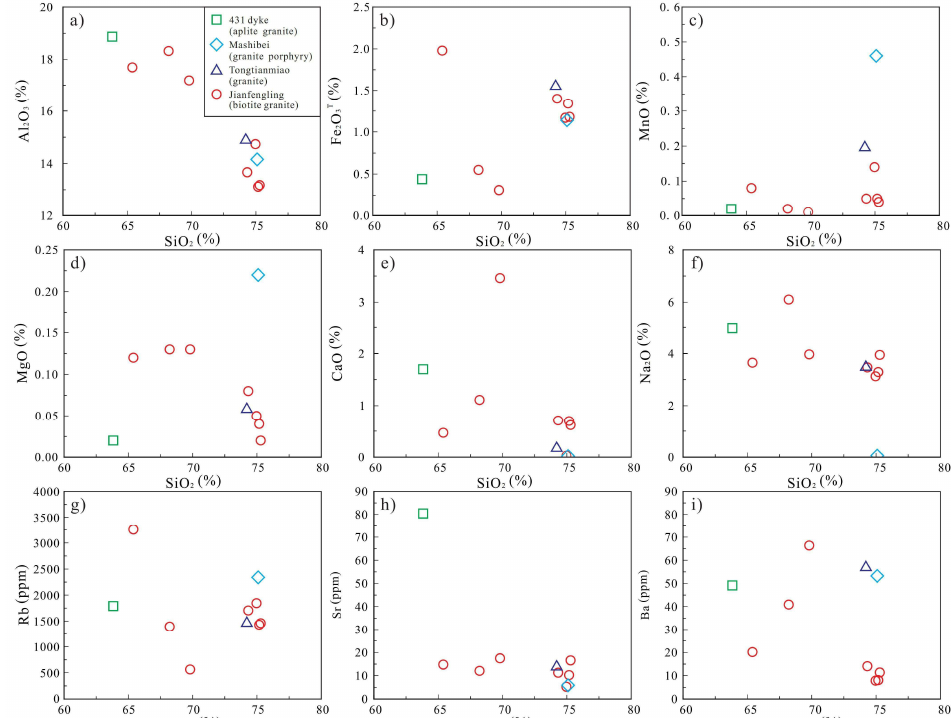
Figure 6. Classification diagram of granite in the Xianghualing ore field. ( a ) QAP diagram [33]; ( b ) TAS diagram [34]; ( c ) R1 vs. R2 diagram [35]; ( d ) A/CNK vs. A/NK diagram [36]; ( e ) SiO 2 vs. K 2 O diagram [37]. In terms of trace element composition, the Xianghualing granitic rocks have high Rb contents (565–3260 ppm) (Figure 5g) but low contents of Sr (5.3–80.5 ppm) (Figure 5h) and Ba (7.9–66.4 ppm) (Figure 5i), with large differences among the aplite dyke, granite porphyry, and granite samples. On a primitive mantle-normalized diagram (Figure 7a), samples from Jianfengling granite show enrichment of Th, Ta, Zr, Ti, and most rare earth elements (REEs) but are depleted in Ba, Sr, etc., relative to other plutons. The sample from the 431 aplite dyke is enriched in Ba, Th, U, K, Zr, Hf, Y, and most REEs; the sample from